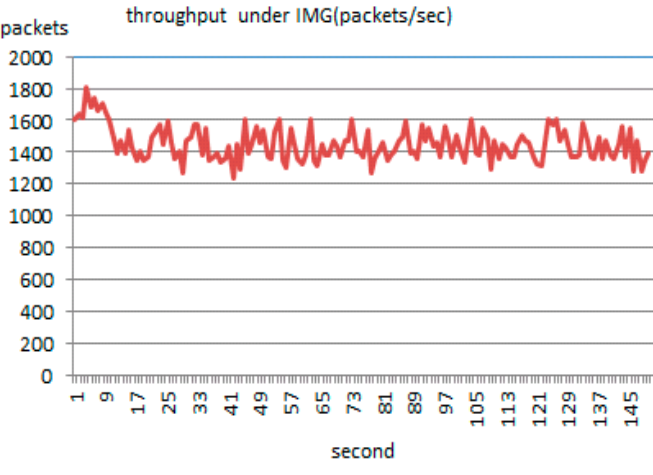
Figure 22. Throughput to the server under IMG (150 s).